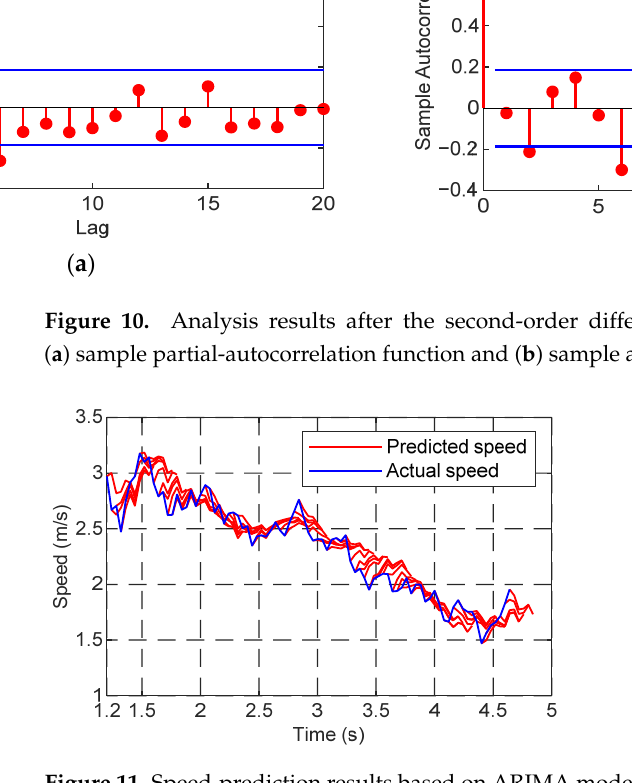
Figure 10. Analysis results after the second-order difference of the original velocity sample: ( a ) sample partial-autocorrelation function and ( b ) sample autocorrelation function.